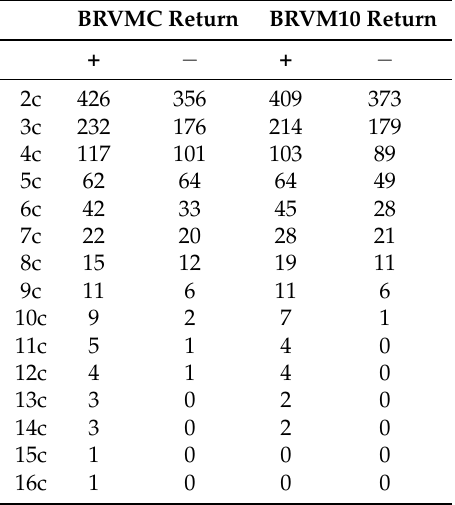
Table 2. Consecutive returns with the same sign.